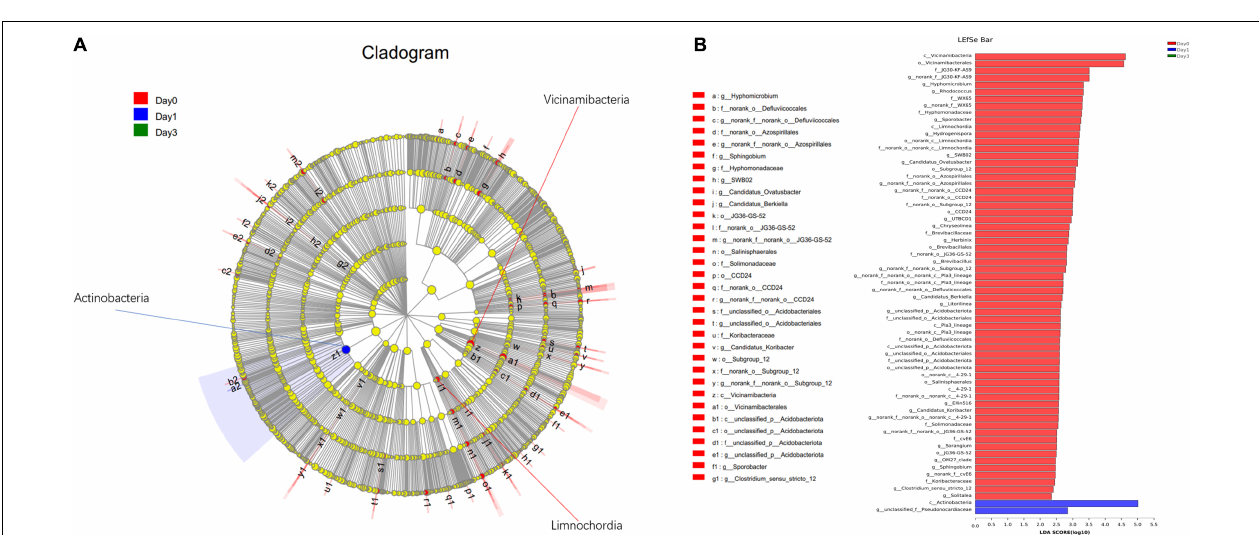
FIGURE 6 | Linear discriminant analysis effect size analysis of differentially distributed genera at Day 0, Day 1, and Day 3 groups. (A) From the center to the terminal, each layer refers to phylum, class, order, family, and genus level, respectively. Each node refers to the specific bacteria with node size proportion to the relative abundance. (B) Specific bacteria with LDA score more than 2 are